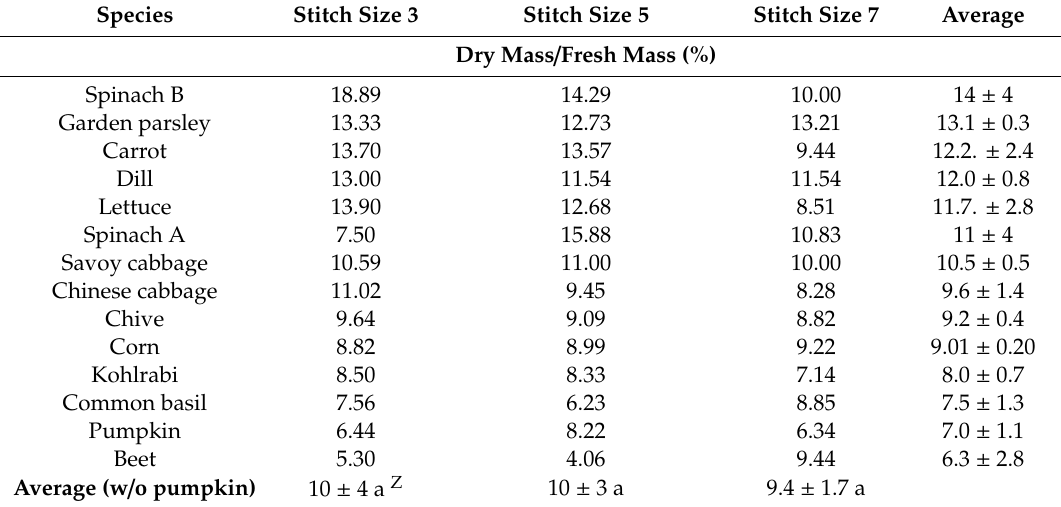
Table 6. Shoot dry mass-to-fresh mass percentages, sorted by the average percentage.